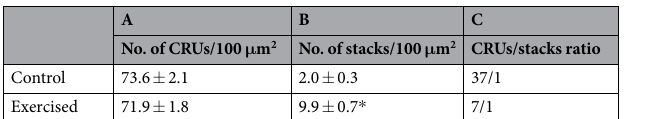
Table 1. The number/area of stacks of flat-cisternae, but not that of triads, increases following exercise. Columns A and B) number/area of CRUs and of stacks of flat- cisternae. Column C) Ratio between number/ area of CRUs and stacks of flat-cisternae. Sample size: control, 2 mice (14 fibers and 5–10 micrographs/fiber); exercised, 3 mice (21 fibers and 5 micrographs/fiber) . Data are shown as mean ± SEM; * p < 0.01 vs.